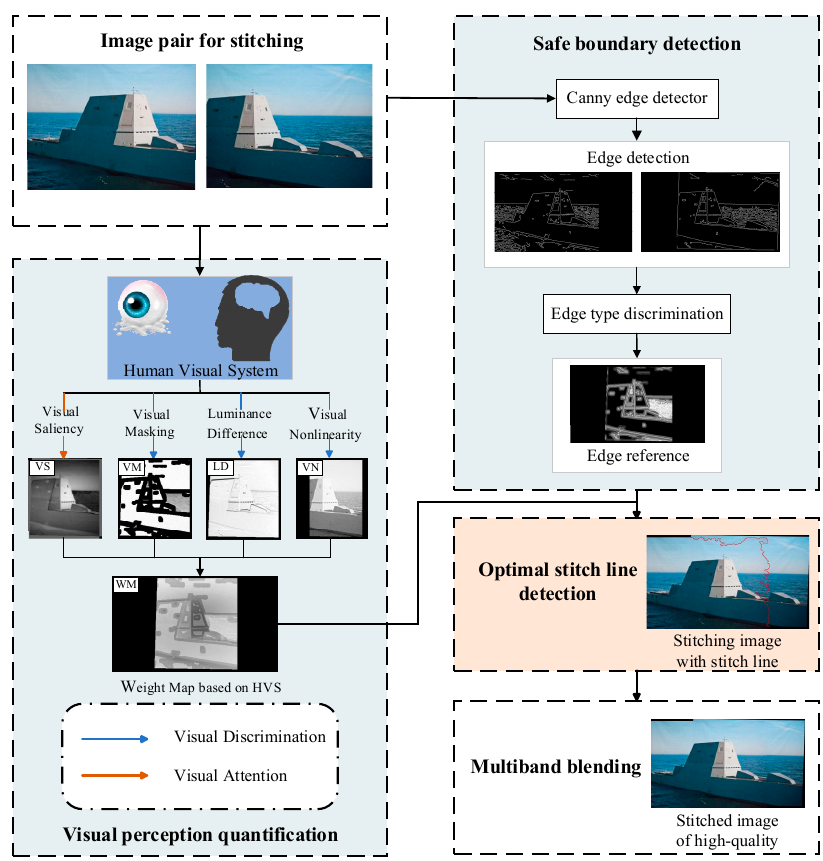
Figure 1. Flow of the proposed method.